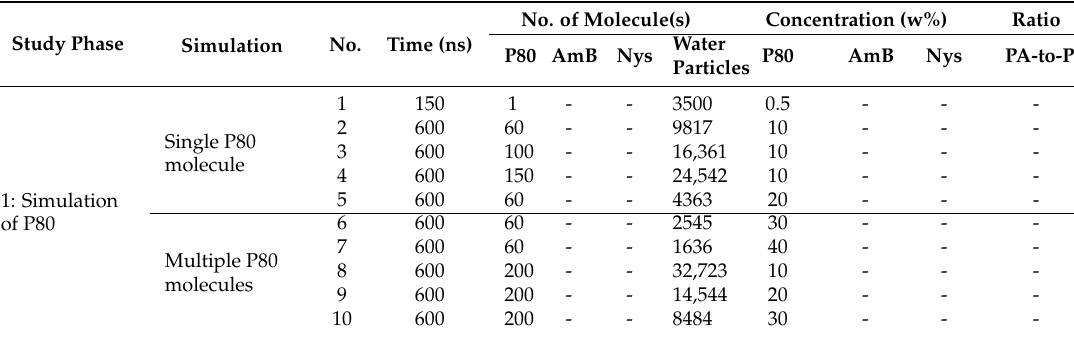
Table 1. Summary of the study